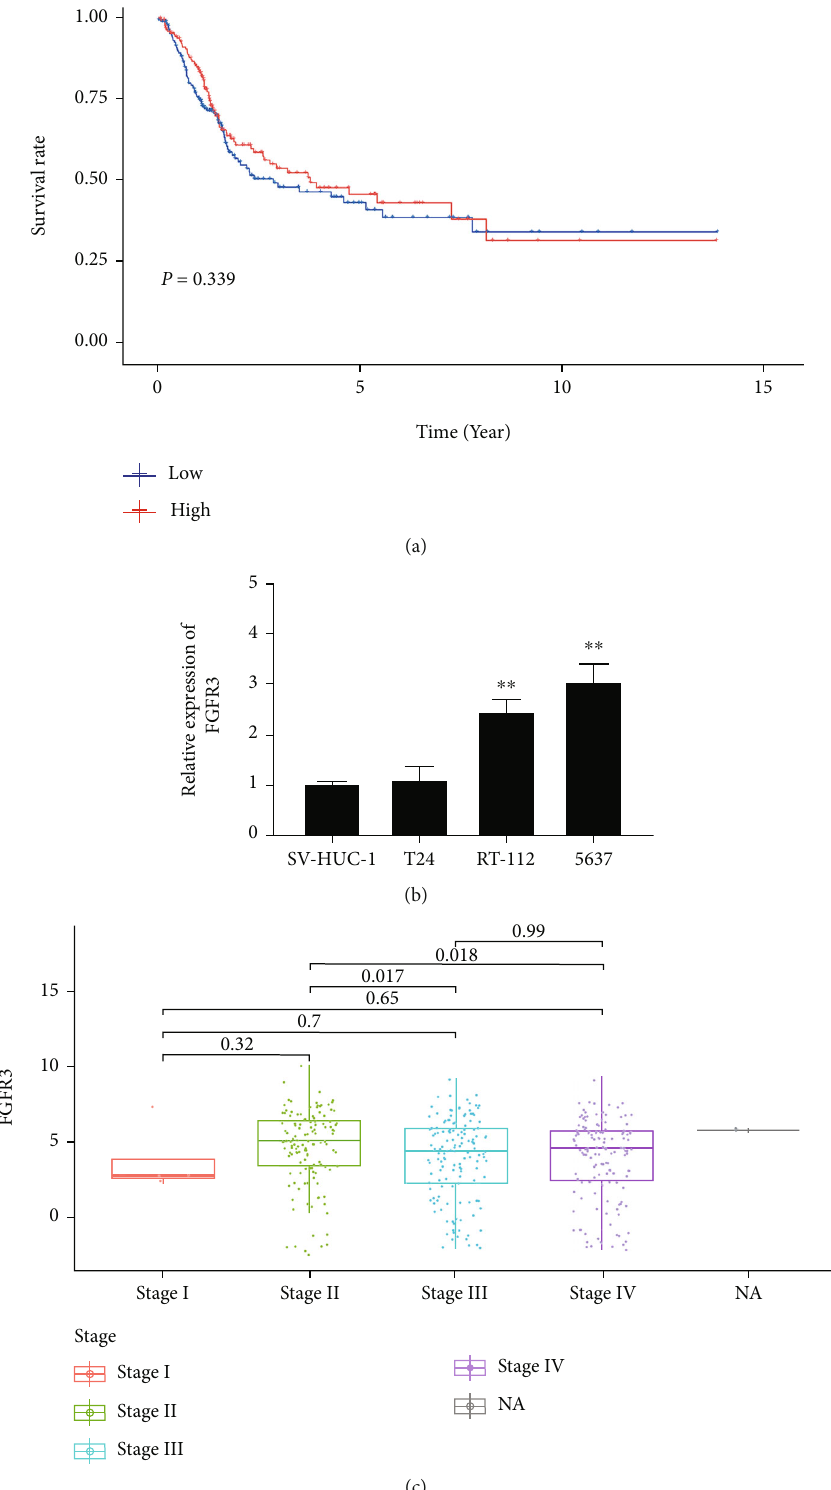
Figure 5: Di ff erential expression of FGFR3 and its correlation with survival time and clinicopathological characteristics of bladder cancer. (a) Survival analysis of bladder cancer patients with di ff erent FGFR3 expression levels. Patients were classi fi ed into groups with high or low FGFR3 expression levels by comparing the median FGFR3 expression level. It was tested by a rank-sum test with p = 0 : 339 . (b) FGFR3 with high expression in RT-112 and 5637 cells. ∗∗ p < 0 : 01 vs. SV-HUC-1. (c) Correlation of FGFR3 expression with clinicopathological features. The Kruskal-Wallis rank-sum test was used for statistical signi fi cance